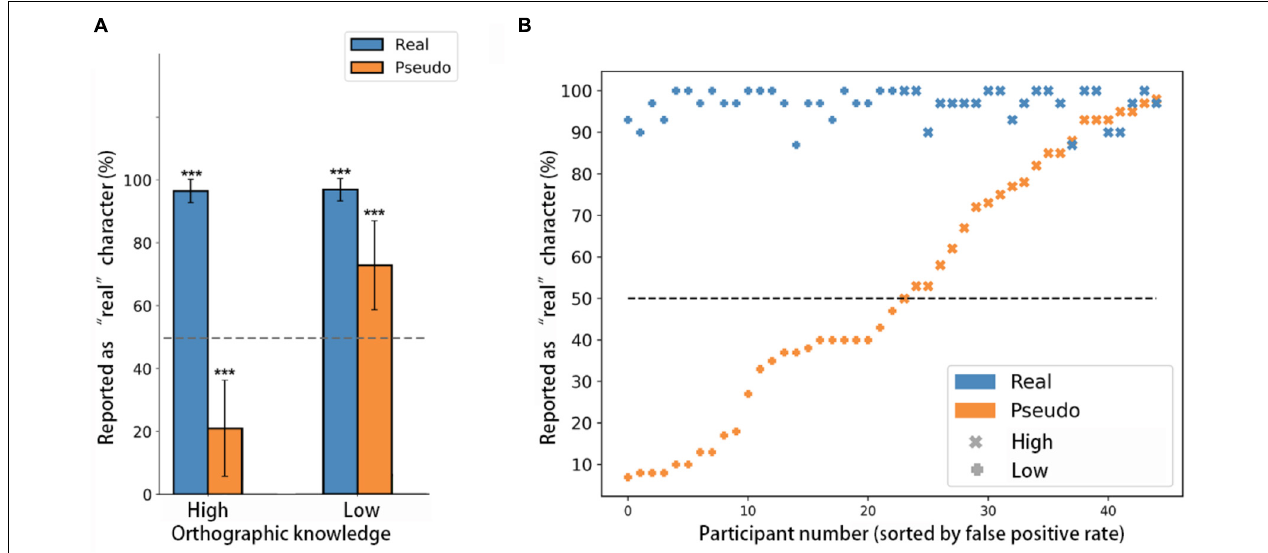
FIGURE 3 | (A) The rate in reporting a stimulus a as real character in the high and low orthographic knowledge groups in the lexical decision task. (B) Same as (A) but showing data points from individual participant. *** p < 0.001.